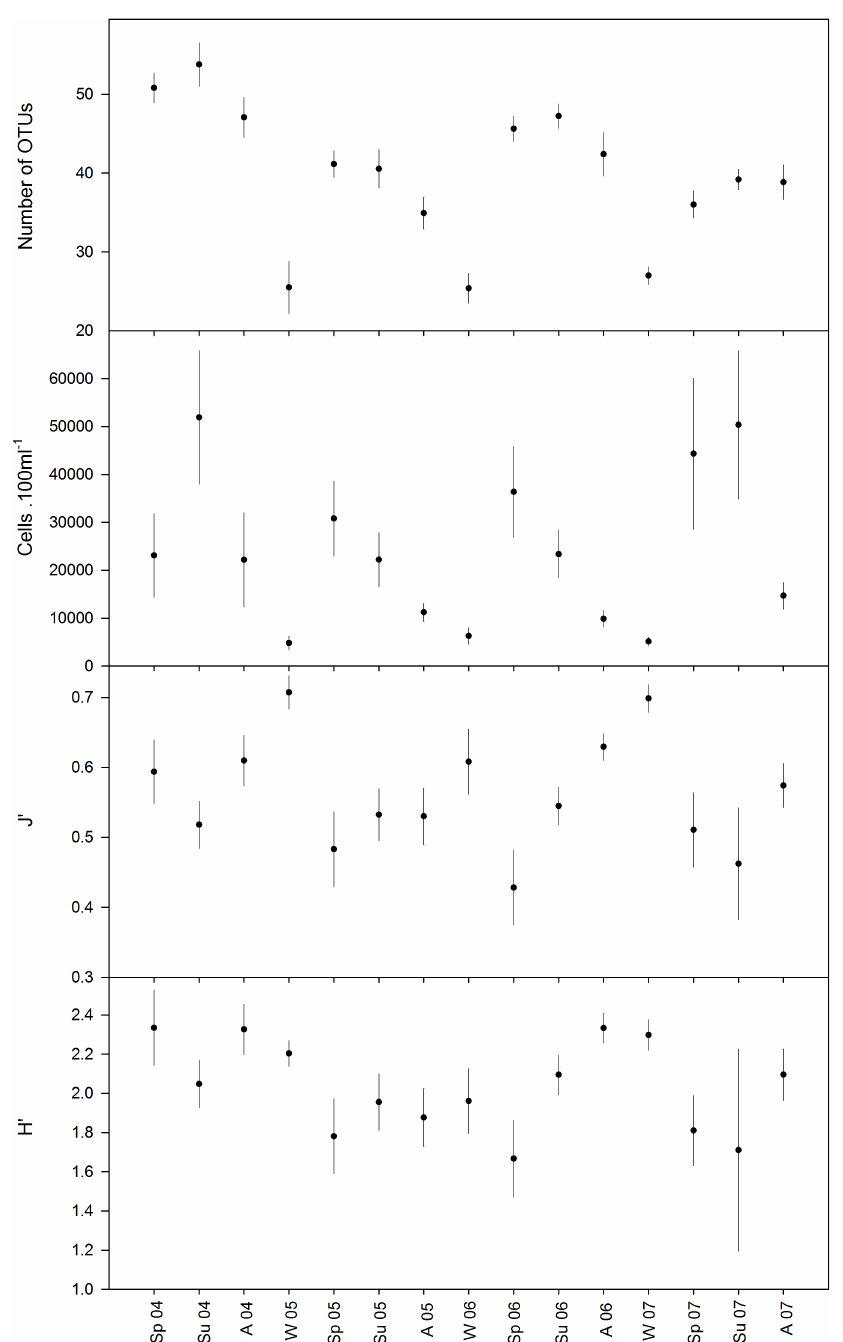
Fig 2. Community structure descriptors of the phytoplankton assemblage throughout the study period. Values shown are seasonalaveragesand respectivestandard error bars. Sp: spring; Su: summer; A: autumn; W: